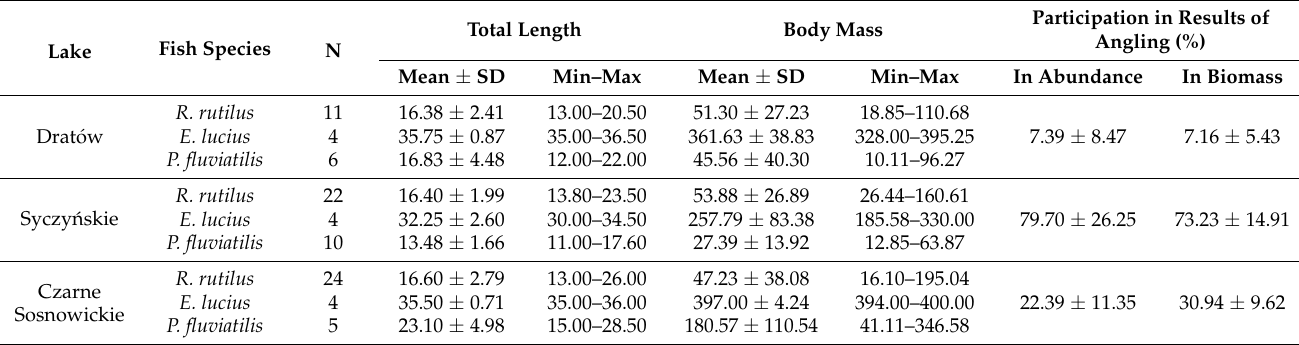
Table 2. The total length (TL, in mm) and body mass (W, in g) of analysed fish and participation of these species in fishing by anglers (%) in 2014–2018 in studied